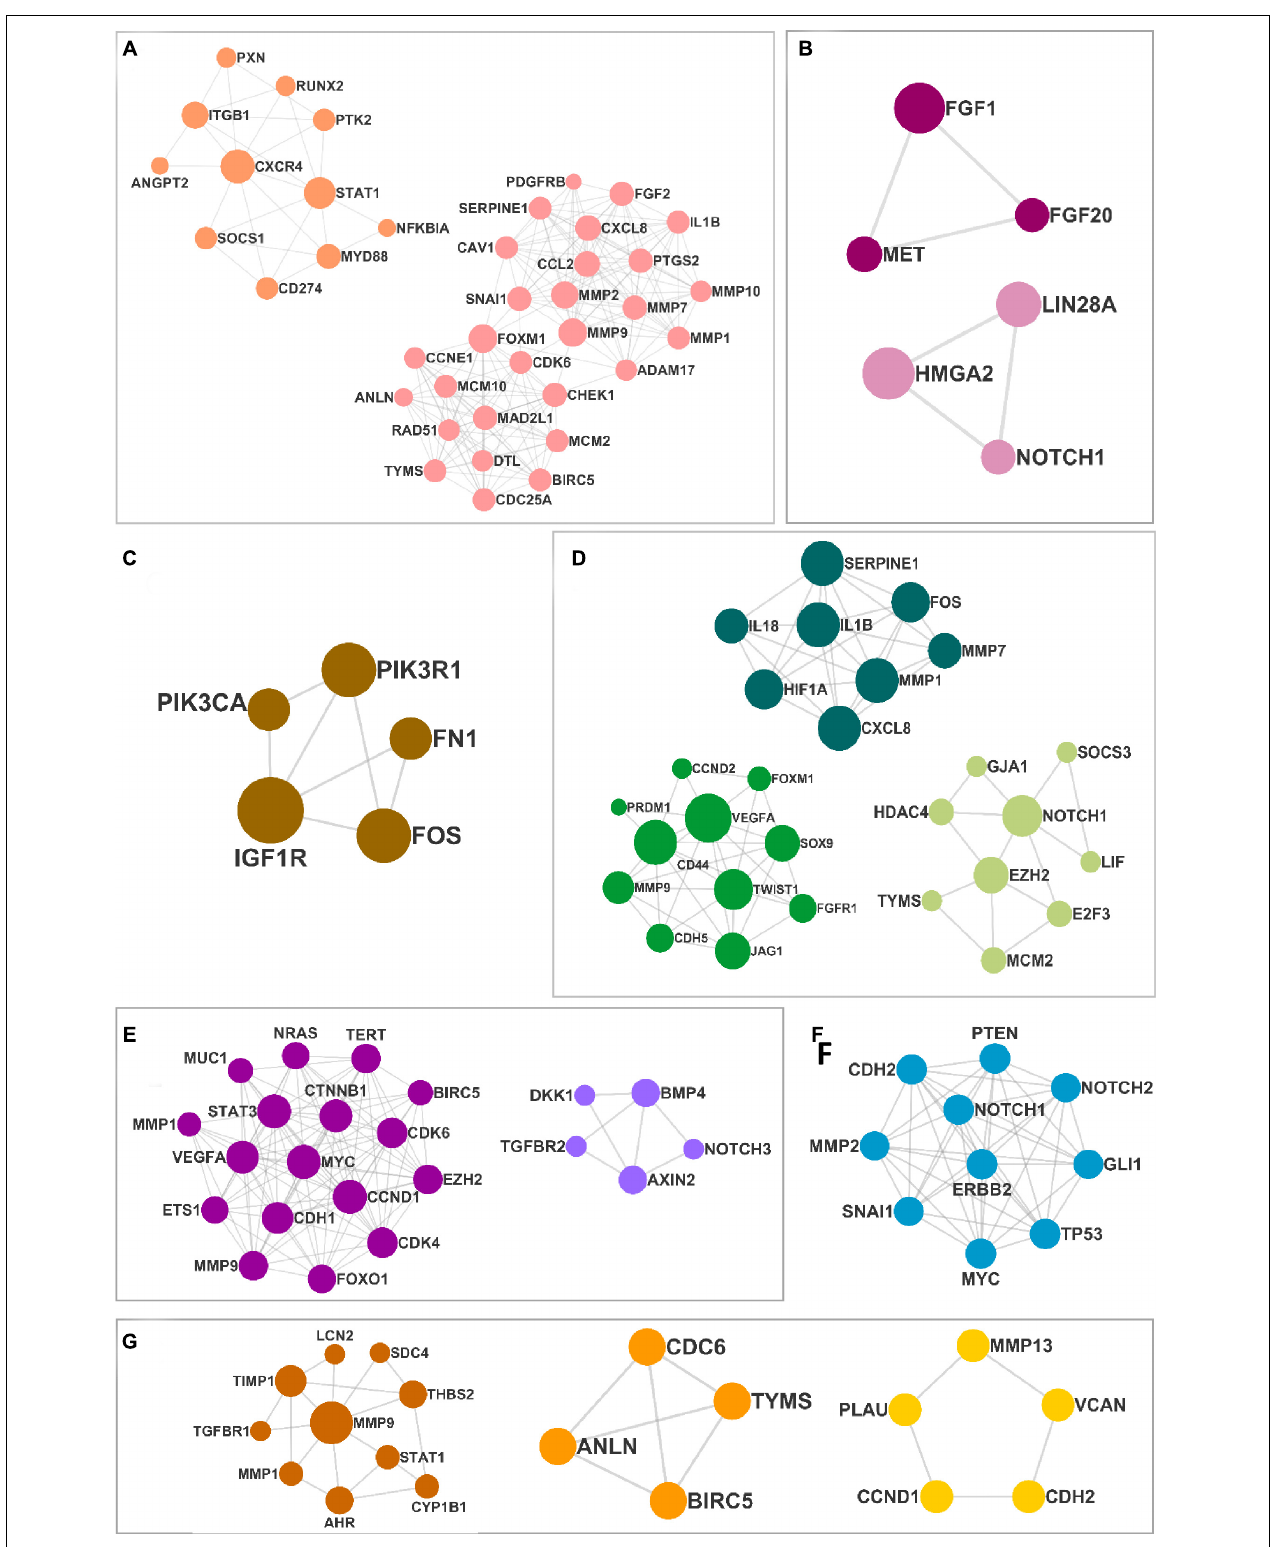
FIGURE 4 | The clusters extracted from the protein–protein interaction network (PPIN) for (A) head and neck squamous cell carcinoma (HNSCC), (B) breast cancer, (C) pancreatic cancer, (D) gastric cancer, (E) liver cancer, (F) lung cancer, and (G) thyroid cancer.